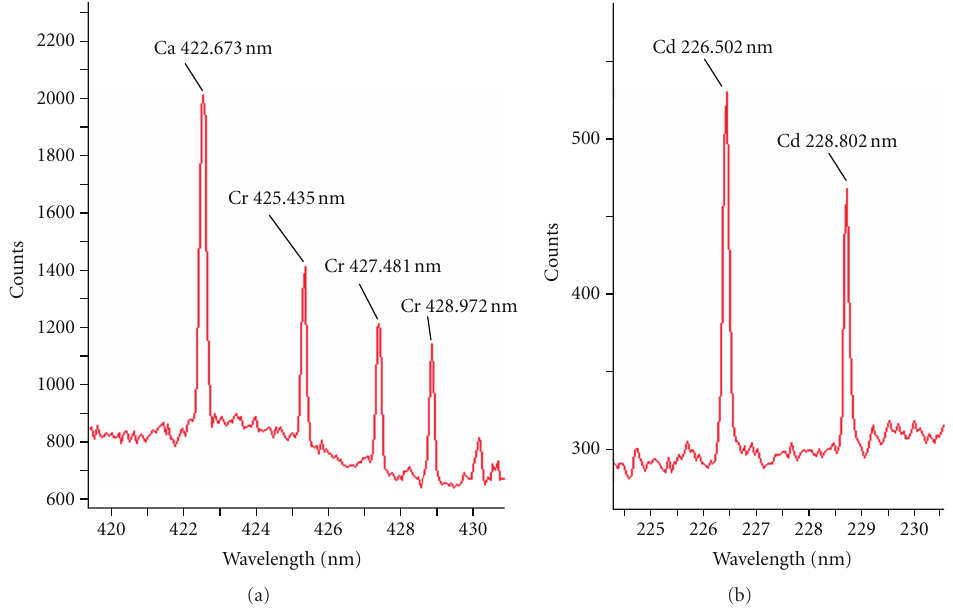
Figure 7: LIBS spectra showing chromium and cadmium lines in Sialkot tannery wastewater sample.